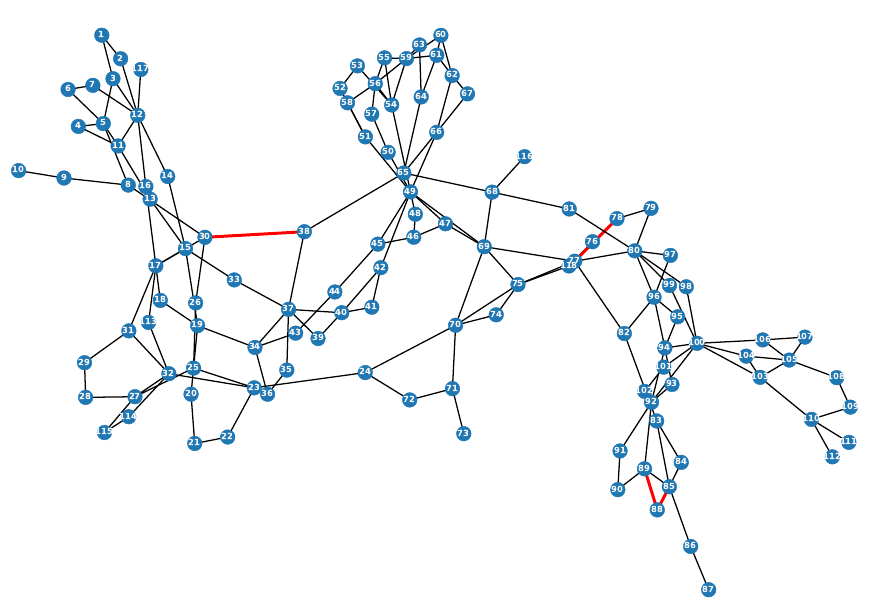
Figure 7. The optimal mobile MSSSC allocation during Season 2 and Season 3. Red lines indicate the mobile MSSSC deployment